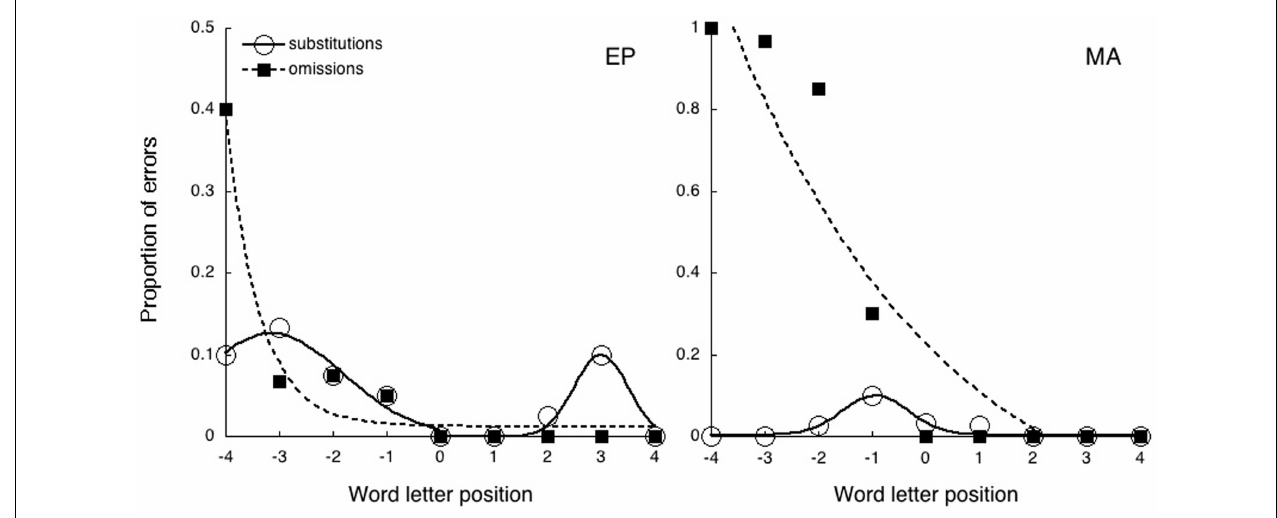
FIGURE 2 |The absolute number of reading errors made by the two patients, divided into substitutions and omissions as a function of letter position .